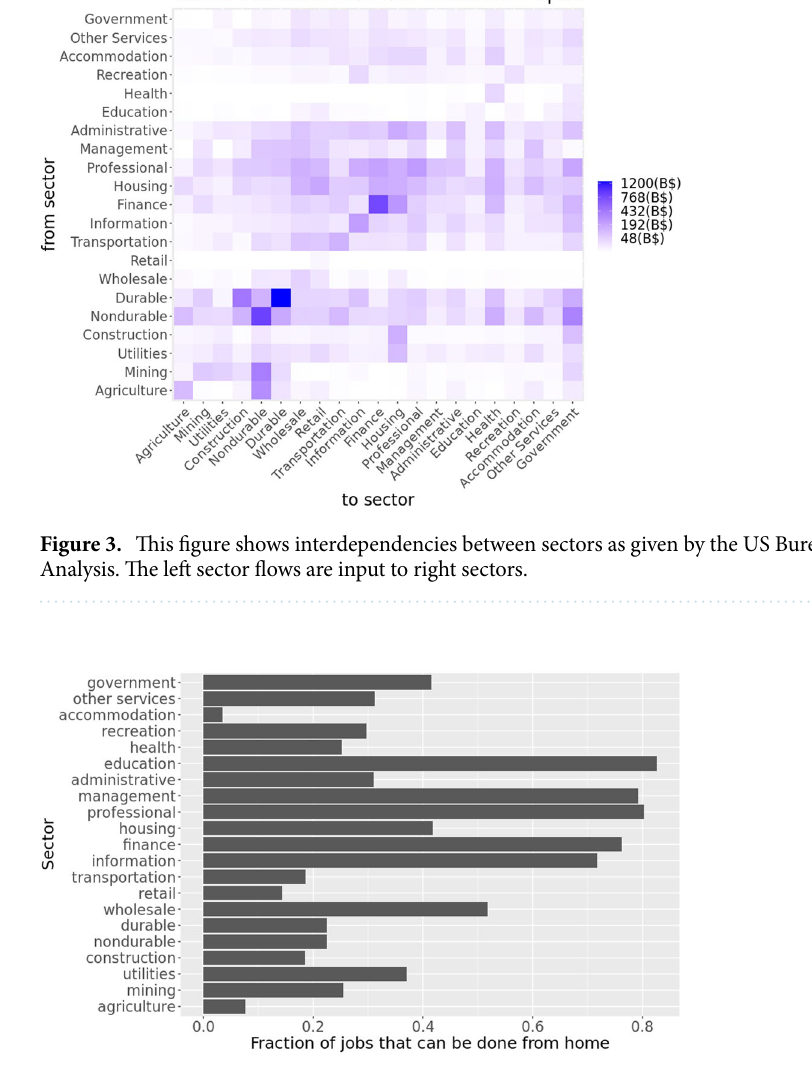
Figure 4. This figure shows the fraction of jobs in each sector that can be done from home. While jobs in accommodation, agriculture, retail, construction, and transportation sectors are difficult to be done from home, those in education, professional, management, finance, and information sectors can be largely operational from